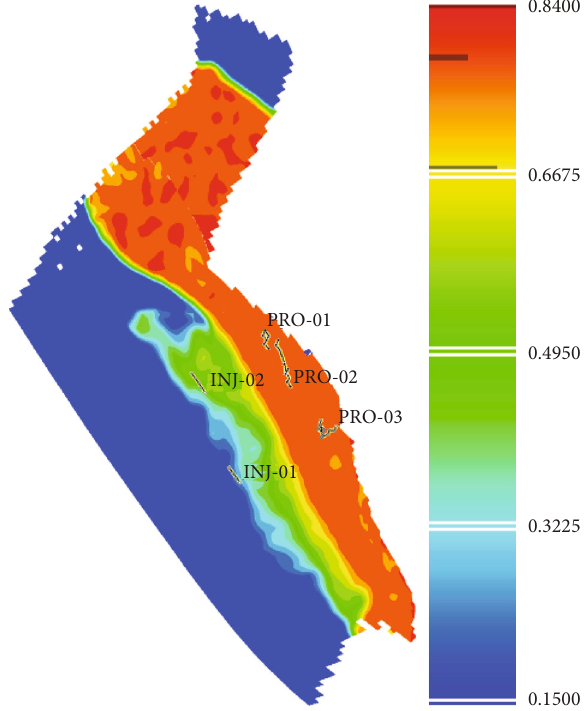
Figure 7: Oil saturation fi eld of L reservoir.